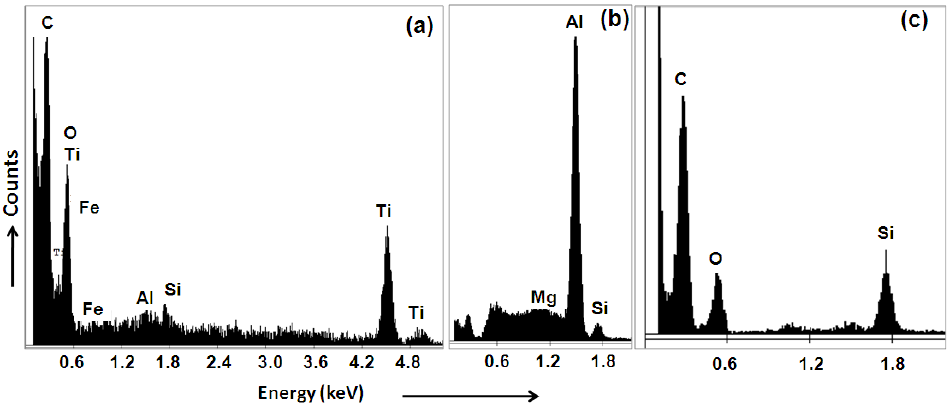
Figure 7: The EDS patterns taken from: (a) top, (b) middle and (c) inner layers of the Fig.6b.